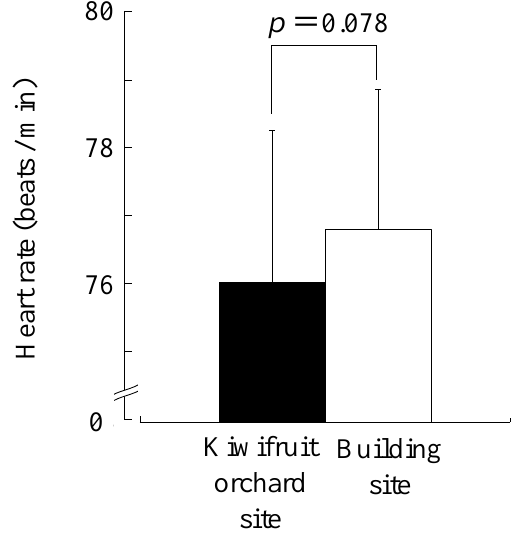
Figure 5. Comparison of the heart rate during 10-min viewing of a kiwifruit orchard or a building site. Data are expressed as the means ± SE; n = 17. p -value by the paired t -test